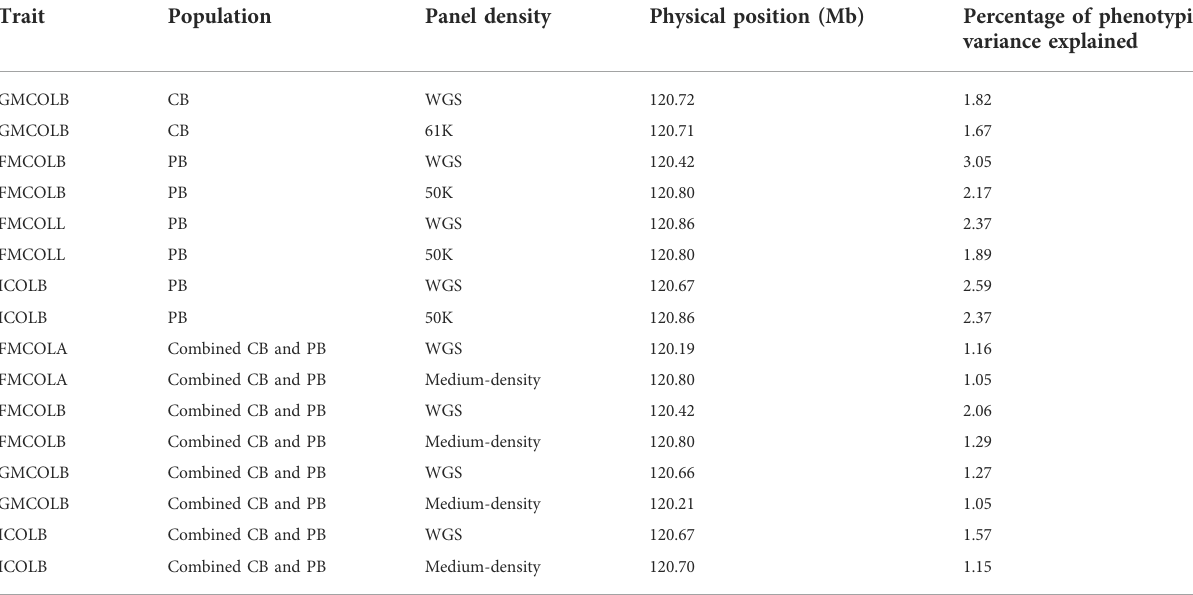
TABLE 10 Percentage of phenotypic variance explained by the most signi fi cant SNP on SSC15 for the pork color traits at differentpanel densities and different populations.